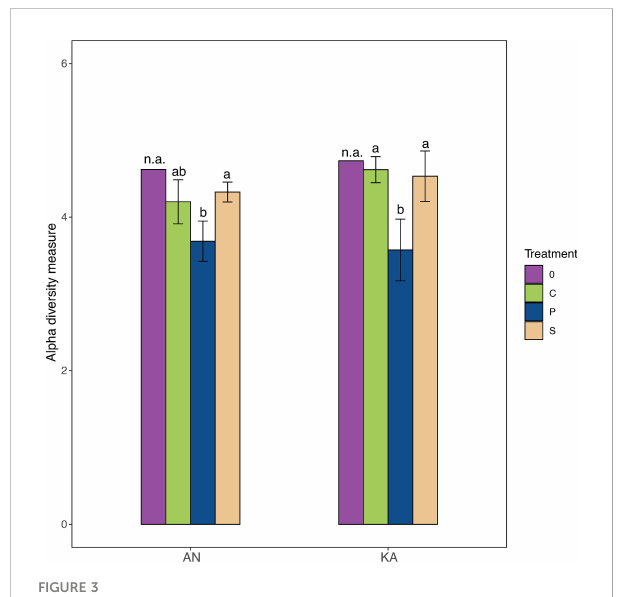
FIGURE 3 Alpha diversity (Shannon – Wiener diversity index) of samples in different treatment for Kalvarsskatan (KA) and Ängerån (AN) at the start (day 0, before DOM amendments) and end of the experiment (day 2). The colours in the graph represent different treatments, with purple representing day 0, green representing control, blue representing plankton extract treatment, and brown representing soil extract treatment, day 2. Error bars represent the standard deviation. The letter s “ a ” and “ b ” placed above each bar indicate signi fi cant differences ( a = 0.05) between the treatments (excluding day 0), as determined by Kruskal – Wallis